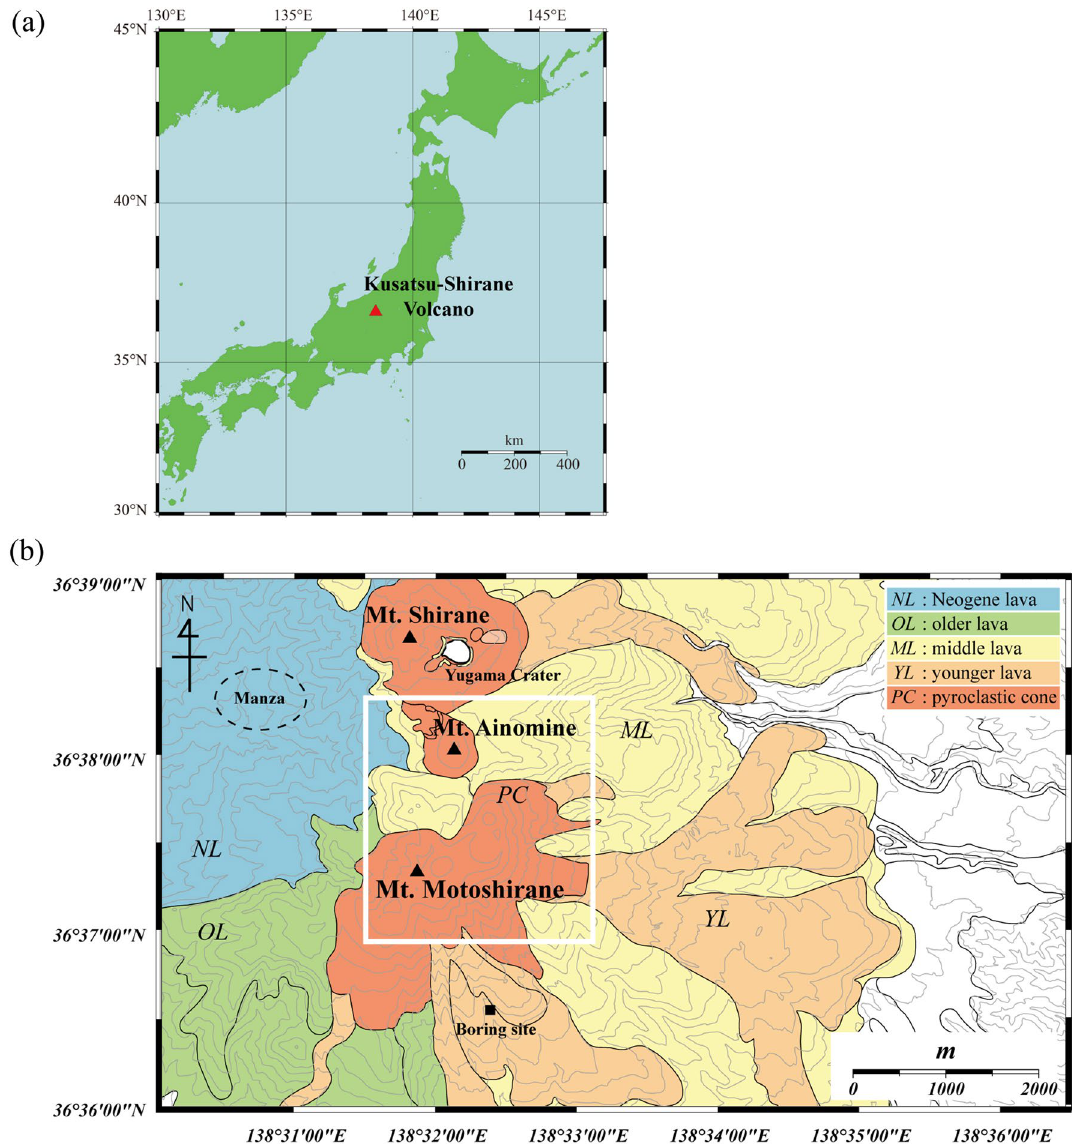
Fig. 1 a Location map of Kusatsu-Shirane Volcano, Japan. The red triangle represents the Kusatsu-Shirane Volcano. b Simplified geological map of Kusatsu-Shirane Volcano (KSV) (after Uto et al. 1983). The distribution of lava is colored by its eruptive stage. Neogene lava is the oldest. Pyroclastic cone includes volcaniclastic deposits of Motoshirane Pyroclastic Cone, Ainomine Pyroclastic Cone, and Shirane Pyroclastic Cone. Black triangles represent three pyroclastic cone groups. The white square indicates the area shown in Fig. 2. The solid square labeled Boring site indicates the location of the geothermal exploration borehole (Gunma Prefecture